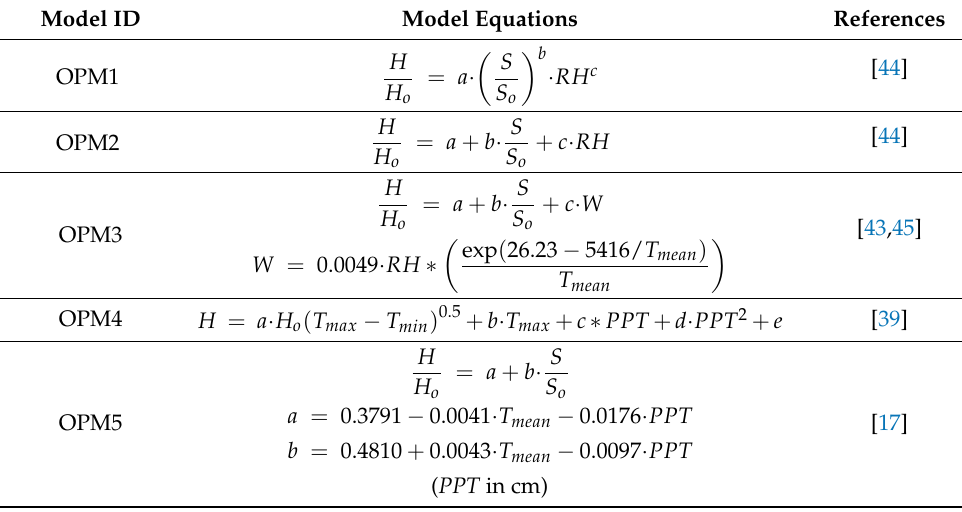
Table 7. Other meteorological-parameter-based models used in this